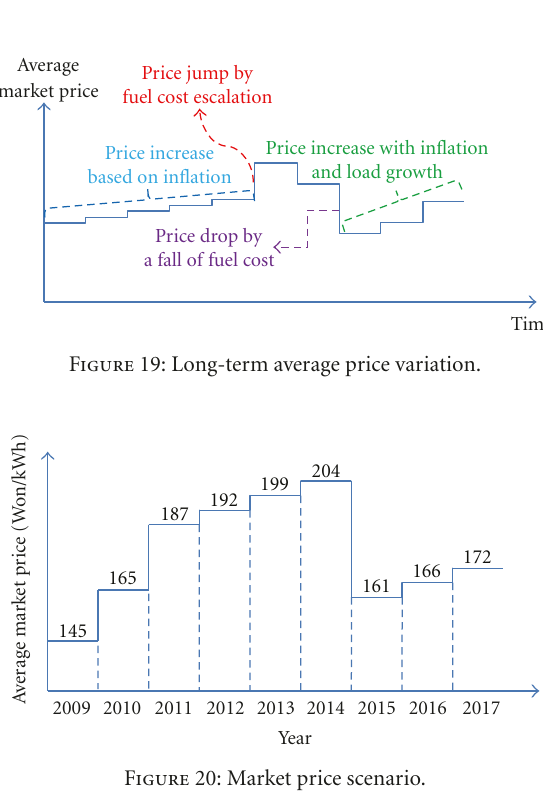
Figure 18: Electricity market clearing prices.